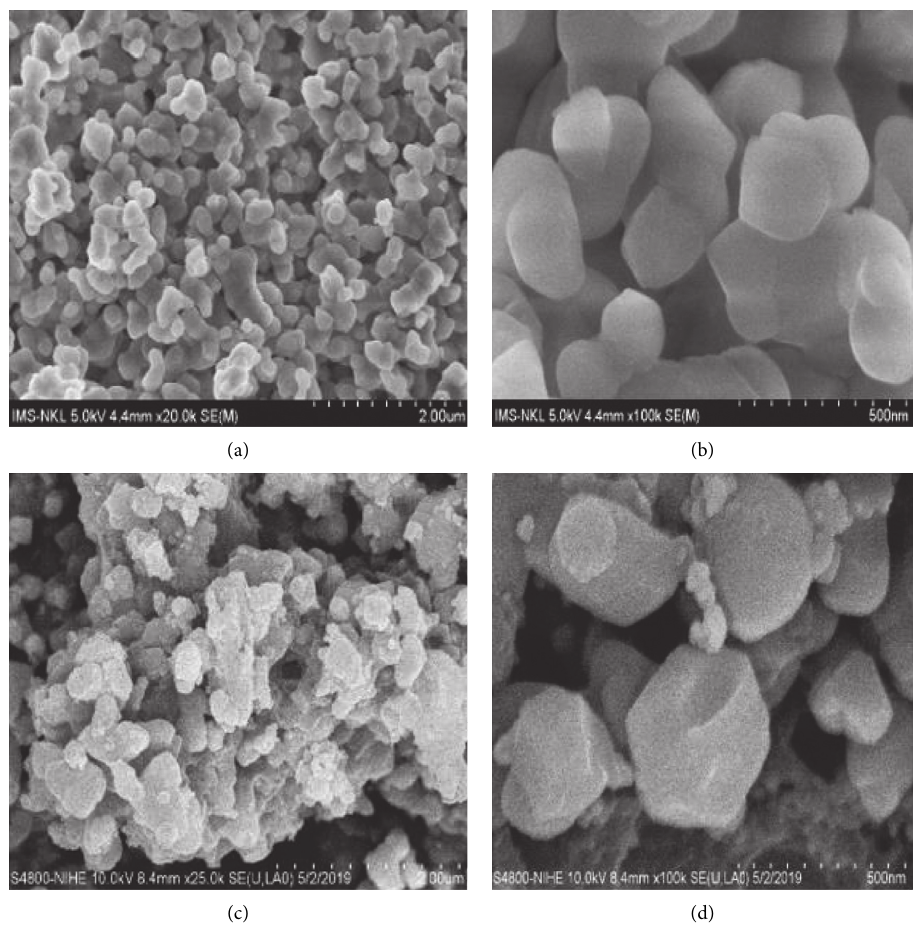
Figure 12: (a, b) SEM image of (hydroxyapatite) HAp and (c, d) HAp@Ag nanocomposite.